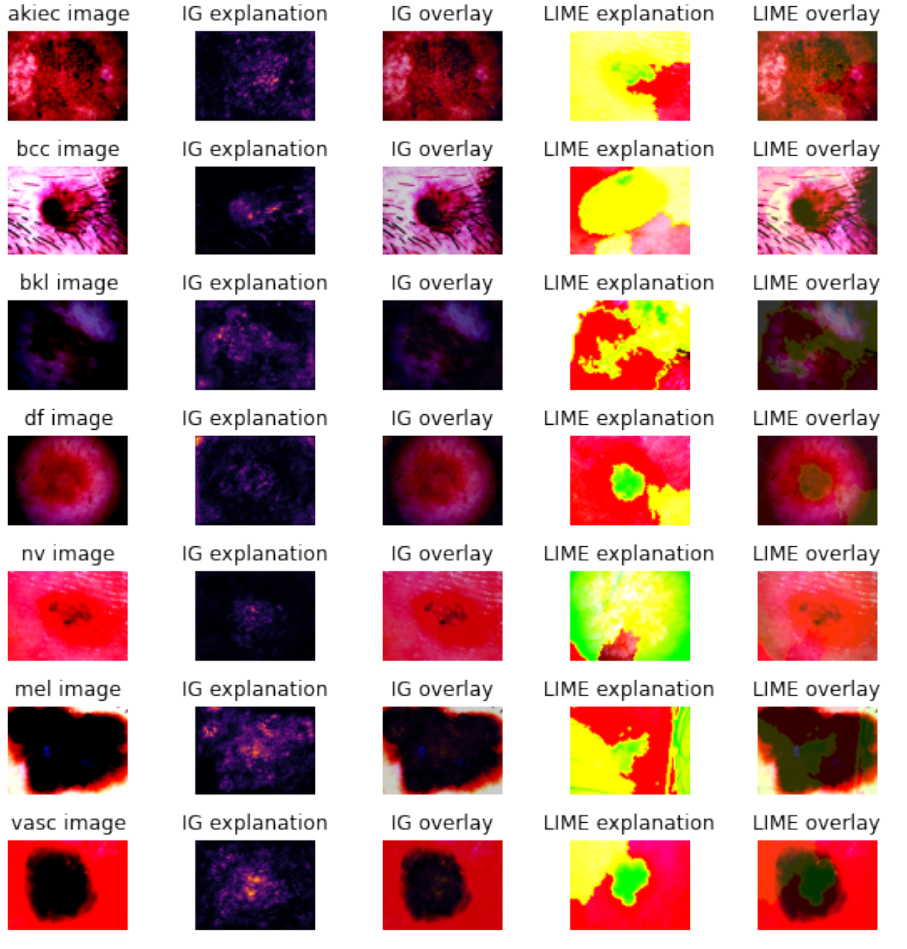
Figure 4. Attribution maps/visual explanation of the explanation techniques for the true positive with the highest probability in the test set for each class. From left to right: original preprocessed image of the class, integrated gradient explanation, integrated gradient explanation overlayed on the true positive image, LIME explanation, LIME explanation overlayed on the true positive